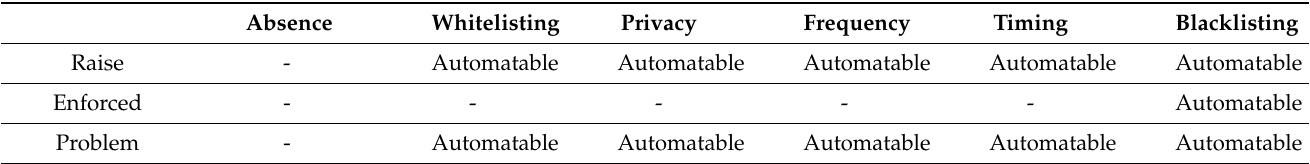
Table 9. Sparse decision automation